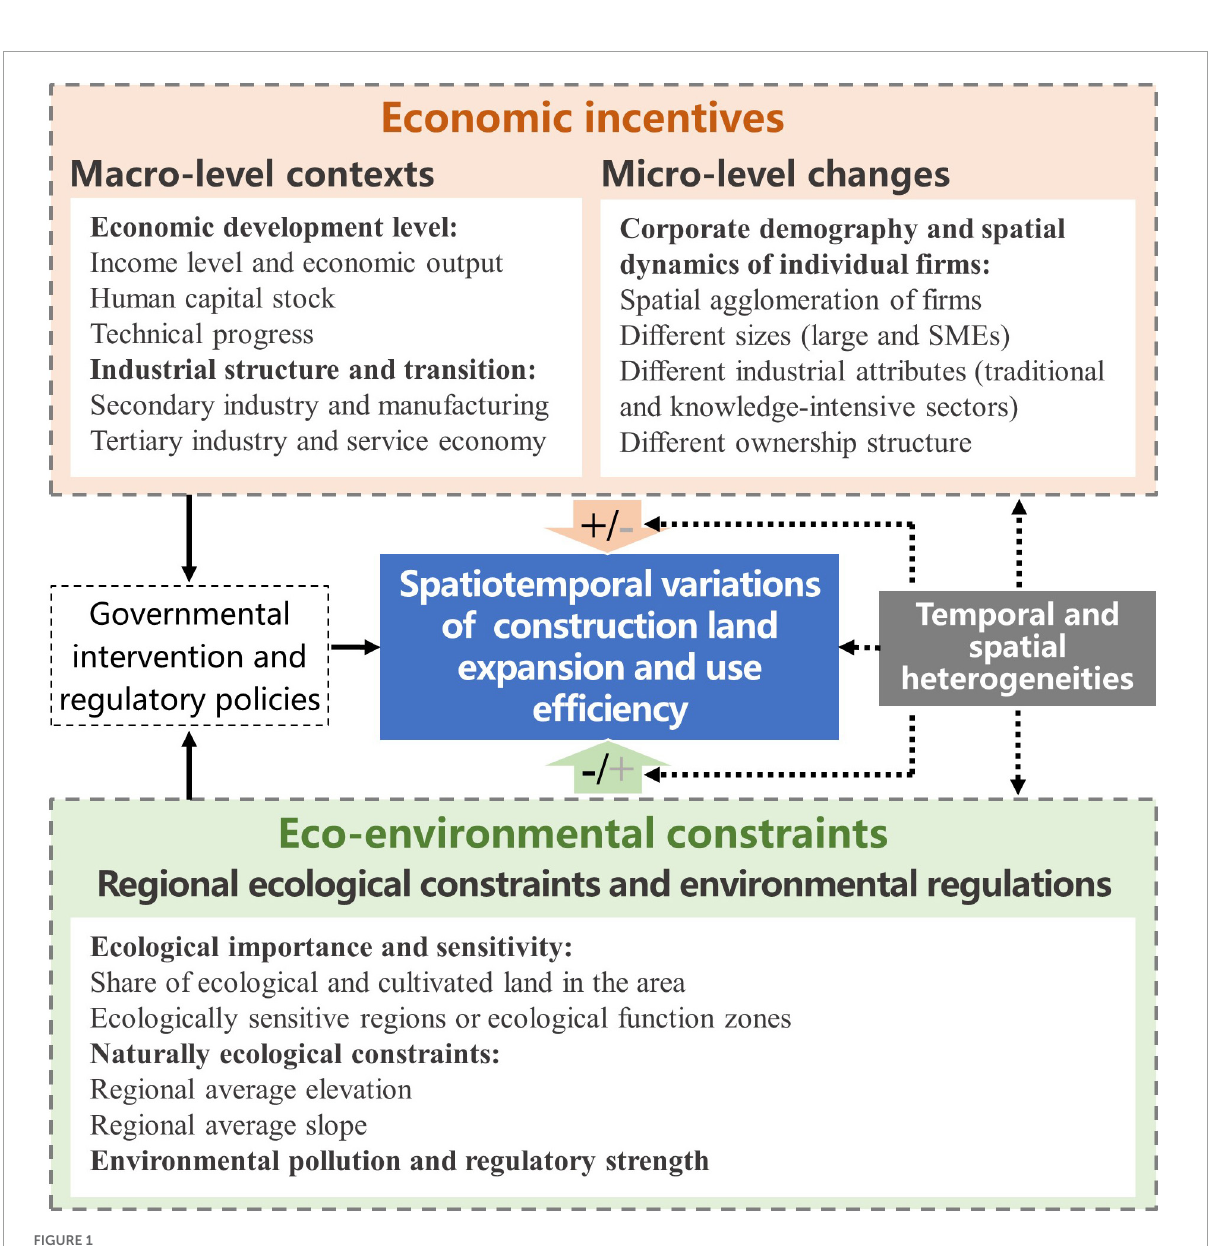
FIGURE1 Conceptual framework of construction land expansion and use efficiency in